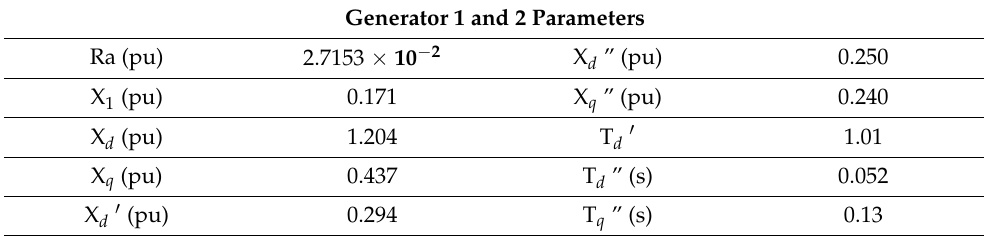
Table 3. Parameter of Generator Impedance and Time